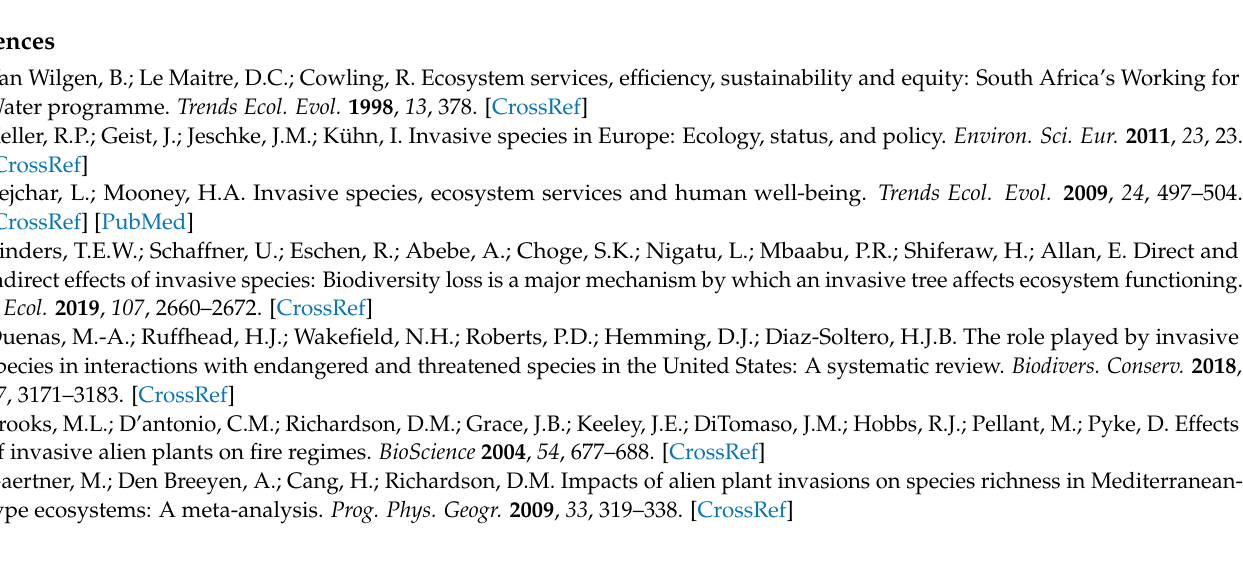
Table S3: Coordinates and altitudes of different locations invaded by Nicotiana glauca in Taif region, western Saudi